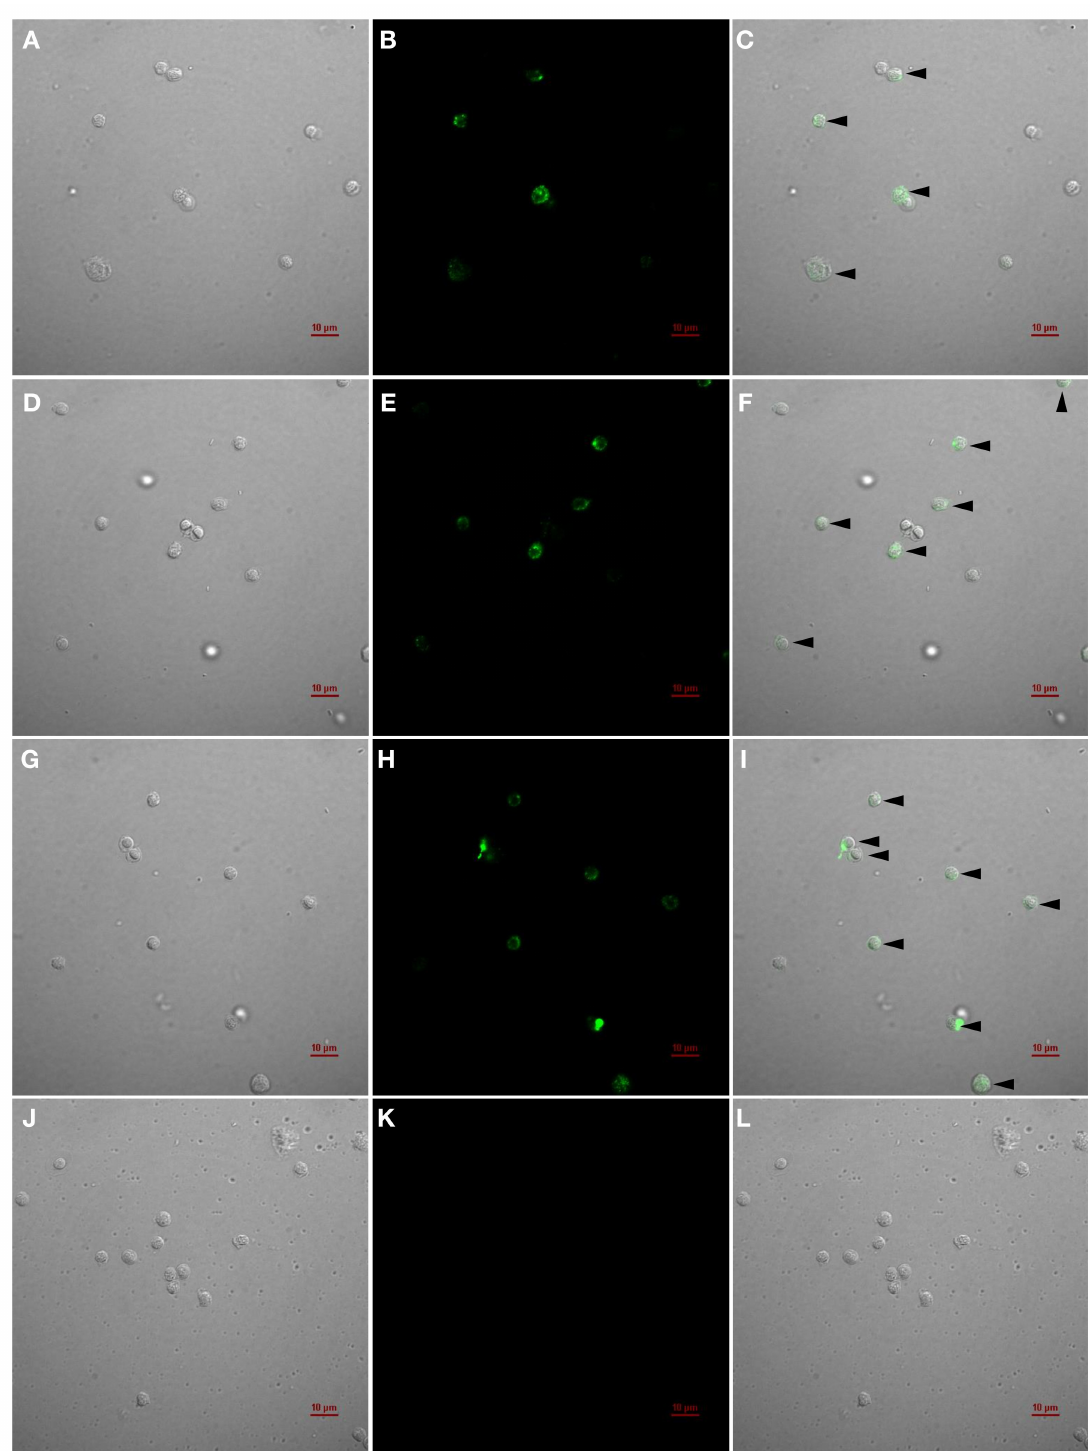
Figure 6. Indirect immunofluorescence analysis of the IgMHC µ 1 mAb by detecting IgM + cells (black arrows) in peripheral blood leukocytes (PBLs) of bighead catfish ( A–C ), African catfish ( D–F ), hybrid catfish ( G–I ) and zebrafish ( J – L